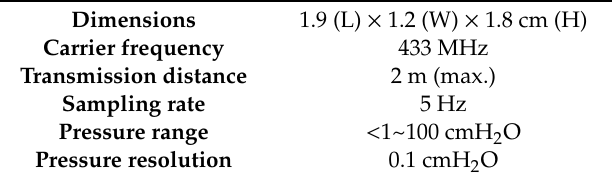
Figure 3. Photos ( a ) before and ( b ) after the hermetic packaging of our implantable pressure sensing system. ( c ) Experimental setup of our system for pressure validation. Table 1. Specifications of the implantable wireless micromanometer system.